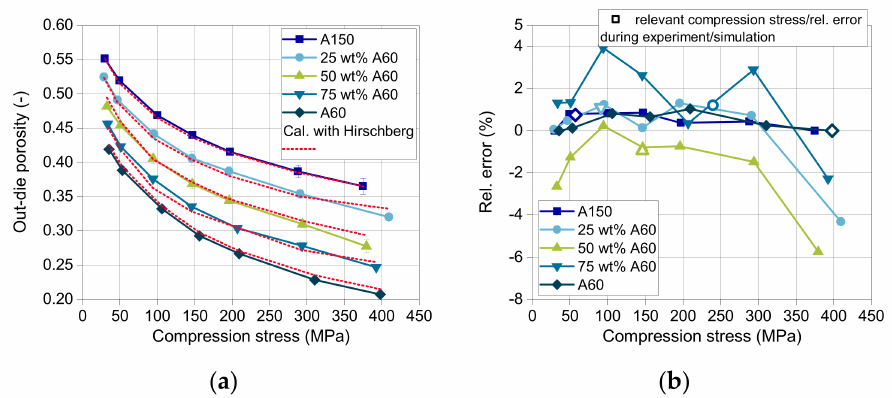
Figure 11. ( a ) Measured (solid lines) and calculated (dotted lines) out-die porosities of DI-CAFOS A60, A150, and mixtures, and ( b ) the relative error between the measured and the calculated data.